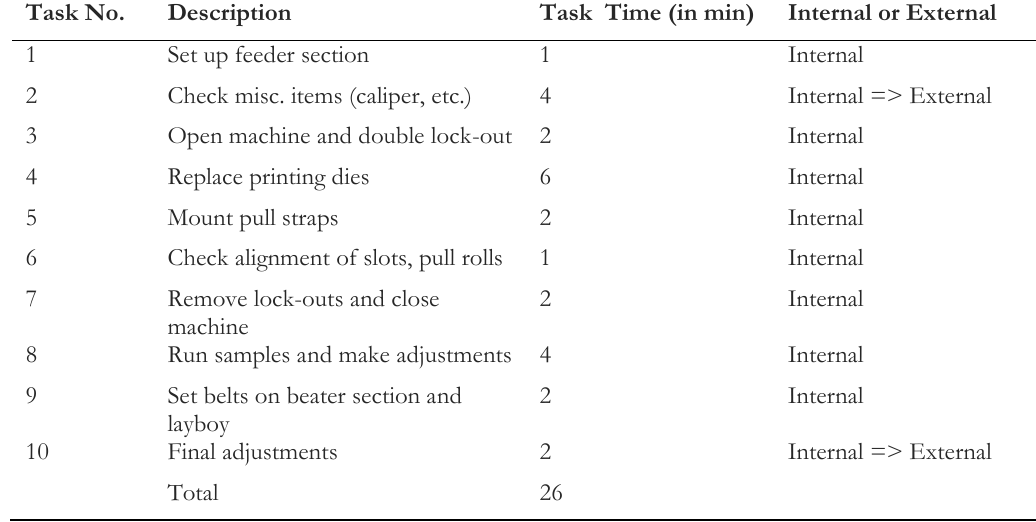
Table 1. Check sheet for identifying setup tasks by operator.